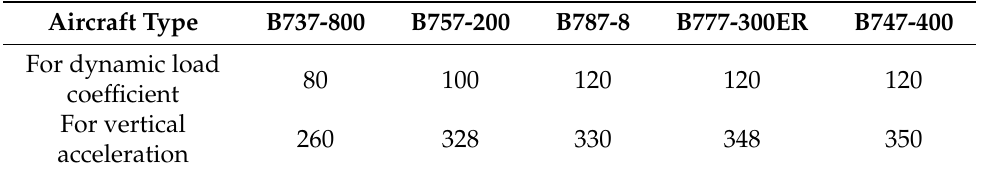
Table 7. Most unfavorable speeds for five types of aircraft (km/h).